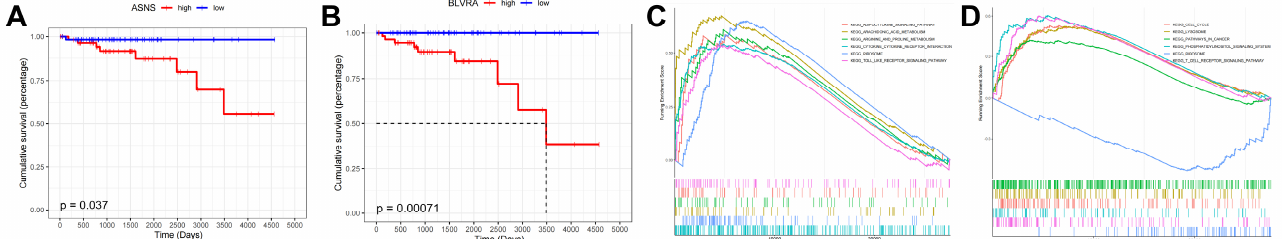
Figure 6. Prognostic value and GSEA of ASNS and BLVRA in thymic epithelial tumors. ( A , B ) Kaplan– Meier curves for groups with high and low ASNS/BLVRA expression in thymic epithelial tumors. ( C , D ) Gene set enrichment analysis (GSEA) showing the differential biology pathways in high and low ASNS/BLVRA expression groups.